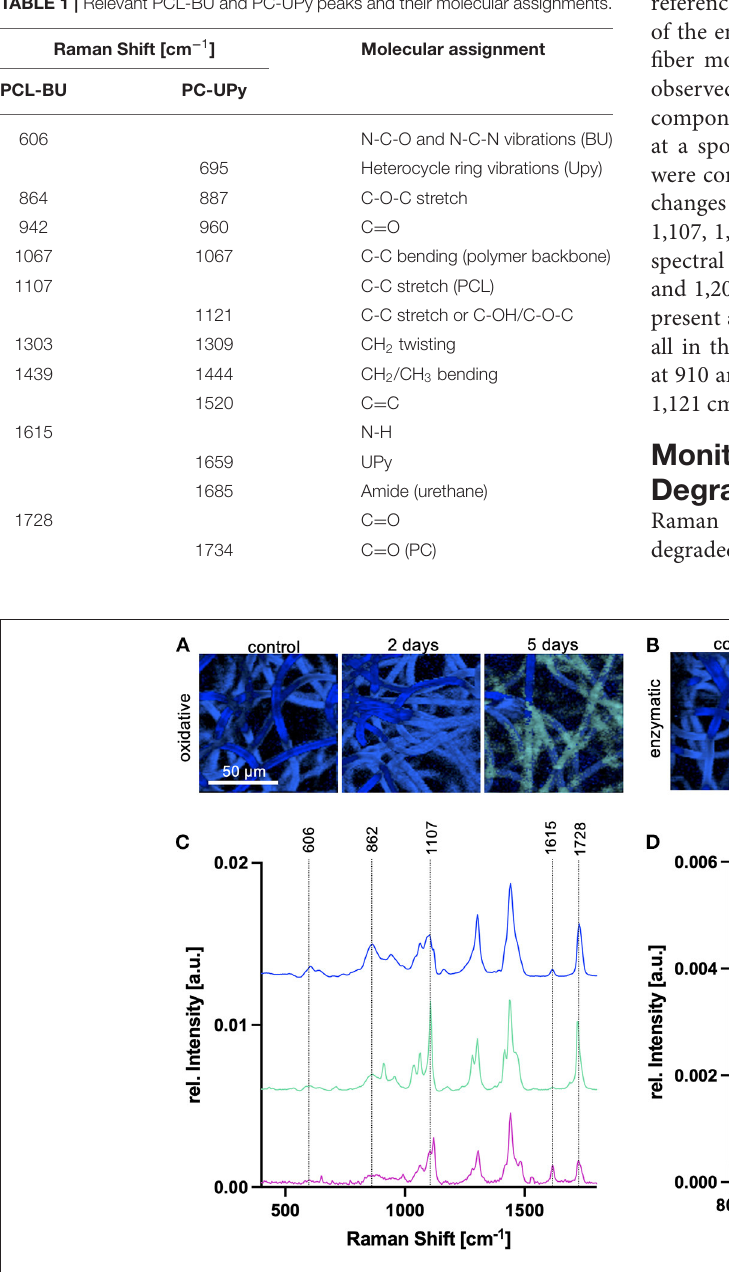
Frontiers in Cardiovascular Medicine |